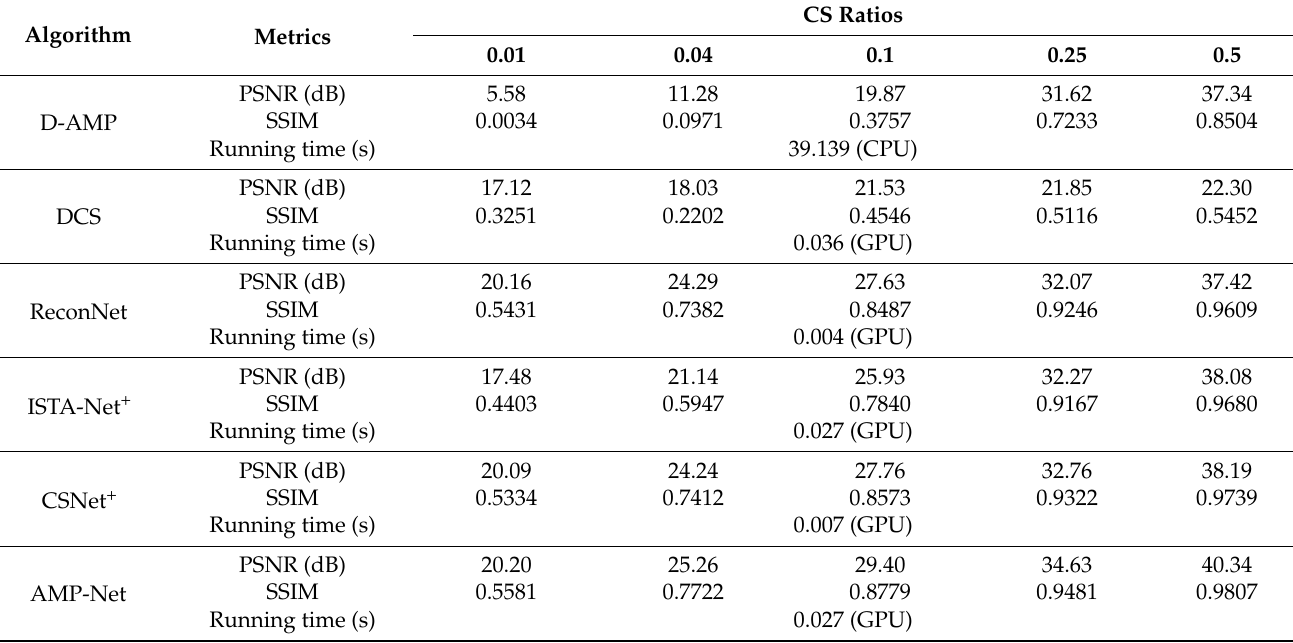
Table 1. Performance comparisons of different image CS algorithms on the Set11 dataset